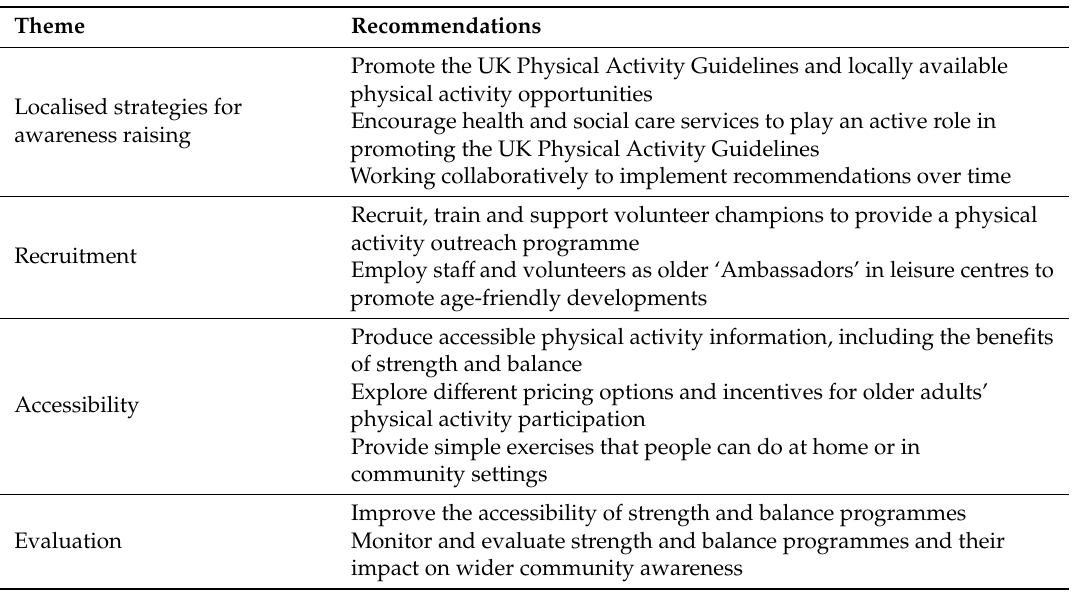
Table 3. Themes and recommendations for change.